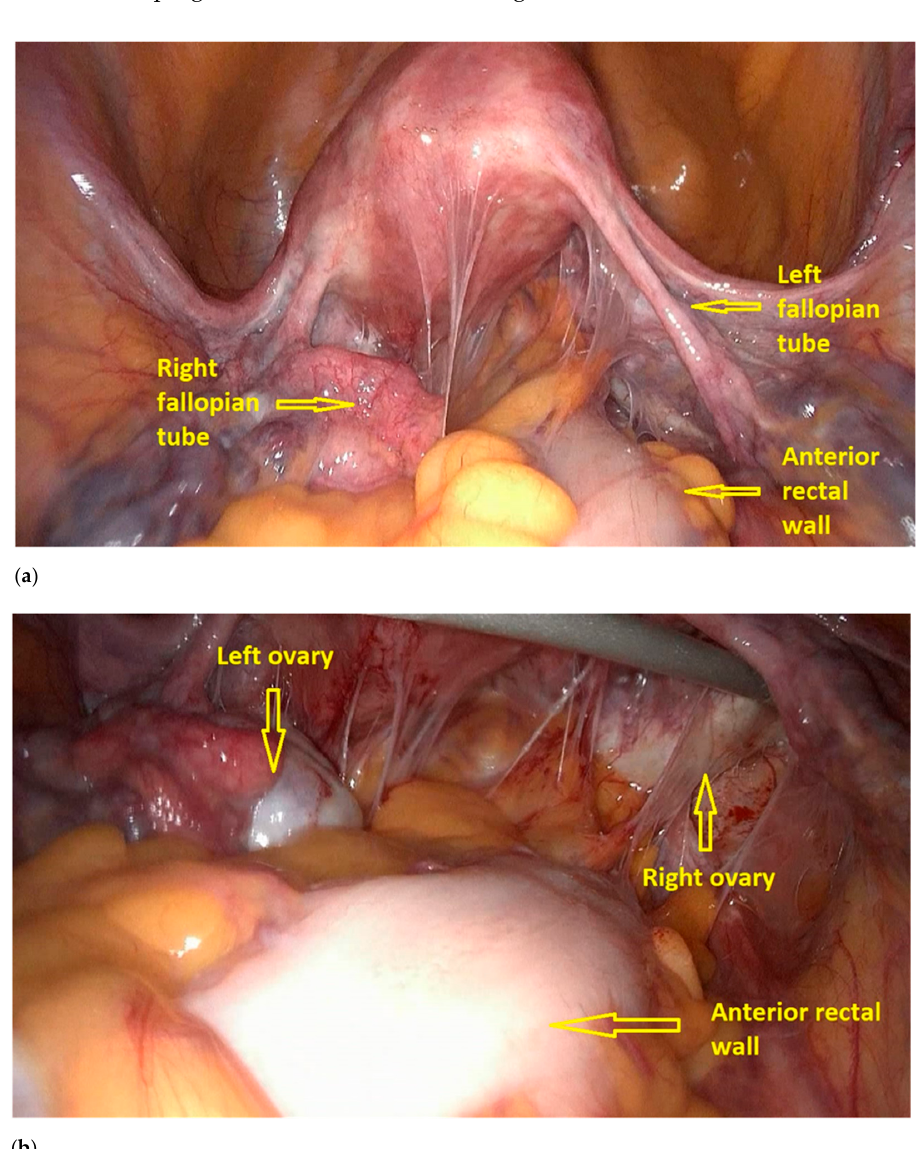
Figure 2. Laparoscopic view of the pelvis. ( a ) Inspection of the pelvic cavity and ( b ) identification of anterior rectal wall.